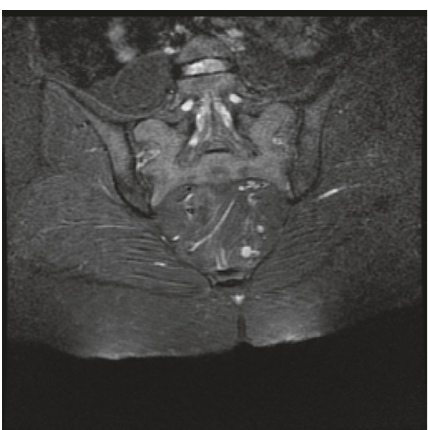
Figure 5: Coronal fat-suppressed T2-weighted MRI scan of the sacroiliac joints in favor of acute sacroiliitis and bilateral sclerosis.